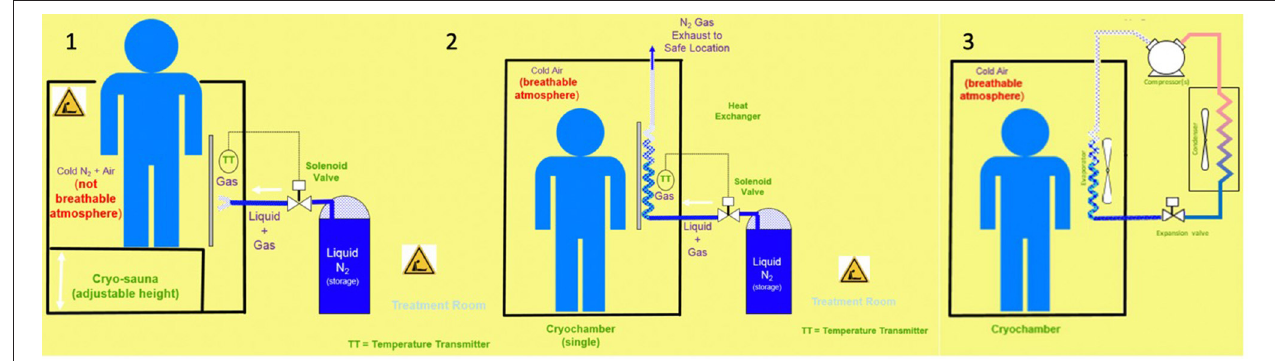
FIGURE 1 | 1: Cryosauna: Principle with liquid N2/direct injection/PBC/individual. 2: Cryochamber: Principle with liquid N2/indirect injection/WBC/individual or collective. 3: Cryochamber: Principle with mechanical refrigeration (single